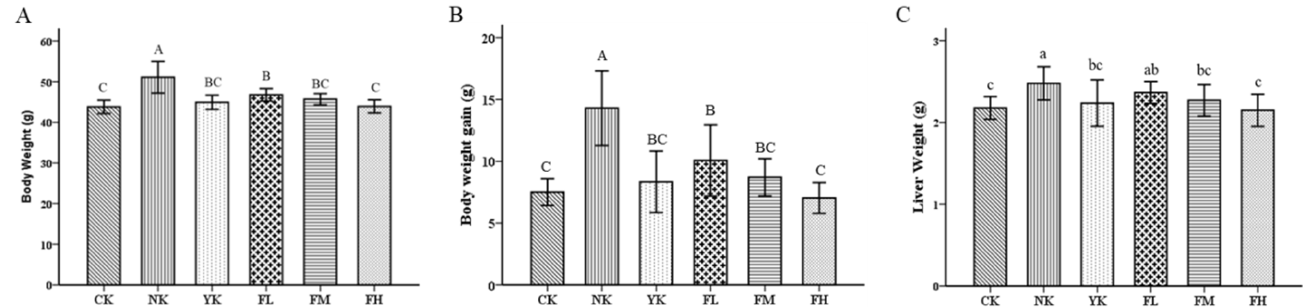
Figure 1. CFBT prevents the increase in body weight and liver weight. ( A ) Body weight, ( B ) body weight gain and ( C ) liver weight. CK, control group; NK, high-fat diet group; YK, high-fat diet with positive drug Xuezhikang; FL, high-fat diet with low-dosage CFBT; FM, high-fat diet with medium- dosage CFBT; FH, high-fat diet with high-dosage CFBT. All data are presented as the mean ± SD ( n = 10/group). Different lowercase letters above the bars showed significant difference at 0.05 level among the same data series; different capital letters showed highly significant difference at 0.01 level among the same data series.